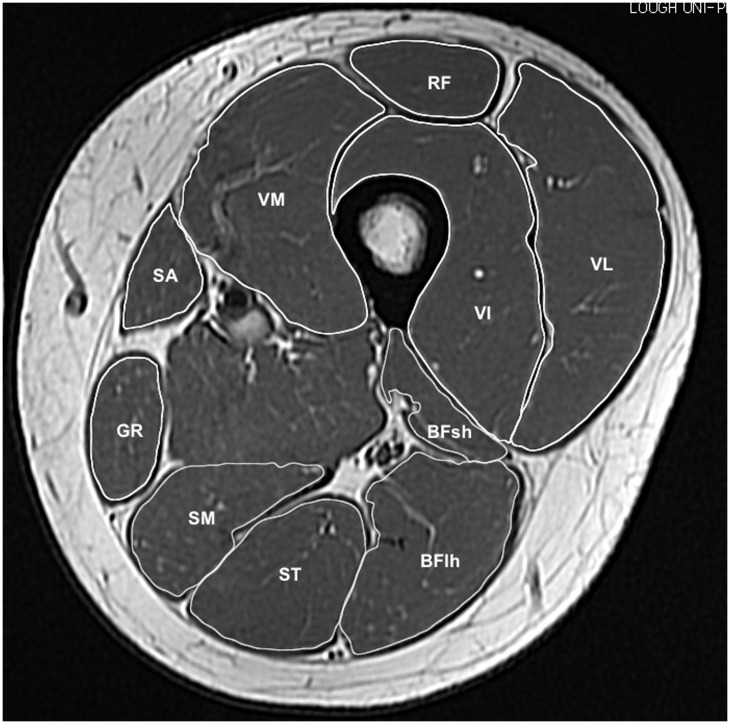
Example of MRI slice mid-thigh with the knee extensors and flexors manually segmented.